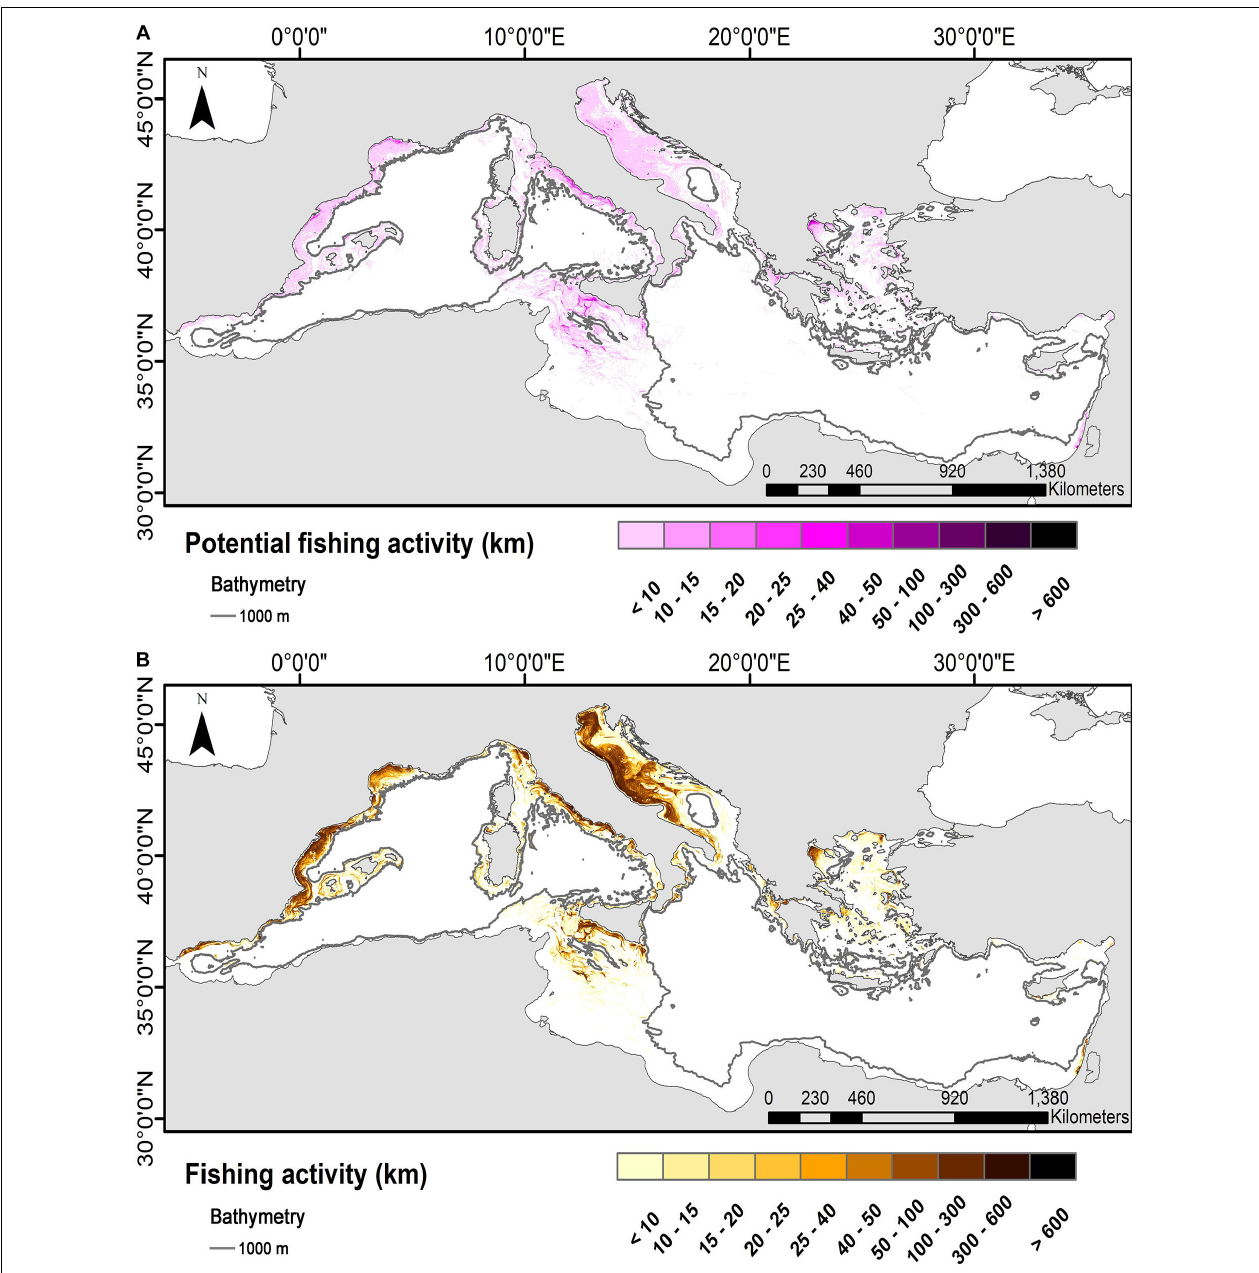
FIGURE 3 | Potential (A) and known annual fishing activity ( Ferrà et al., 2018, B) in the Mediterranean Sea in